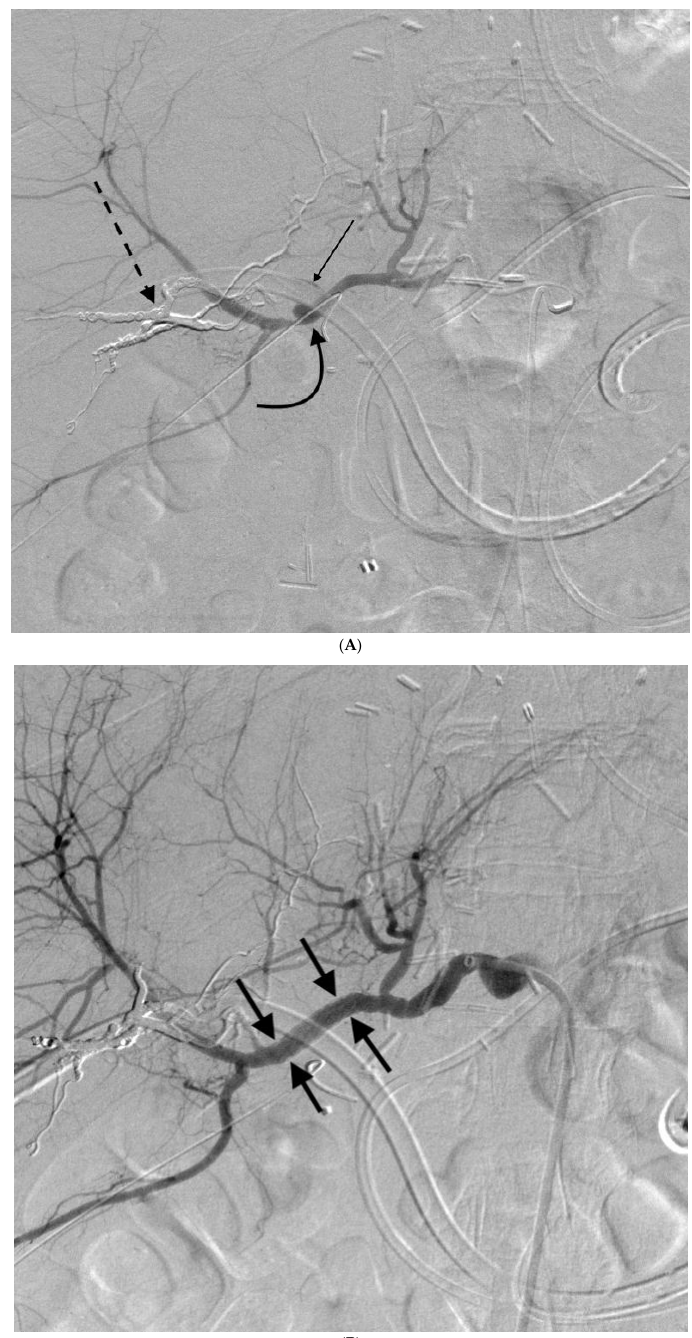
Figure 4. 61-year-old female with hepatic artery pseudoaneurysm caused by PTBD, treated with stent graft placement. Patient underwent deceased donor liver transplant for hepatitis C cirrhosis. She subsequently developed large volume bleeding from her biliary drainage catheter. ( A ) Angiogram showed a hepatic artery to portal vein fistula that was treated with coil and glue embolization (dashed black arrow) as well as a hepatic artery pseudoaneurysm (curved black arrow) adjacent to the crossing biliary drainage catheter with extravasation seen around the catheter (thin black arrow). ( B ) Given the patient’s favorable anatomy, a covered stent (straight black arrows) was placed with desired exclusion of the pseudoaneurysm and cessation of hemobilia.